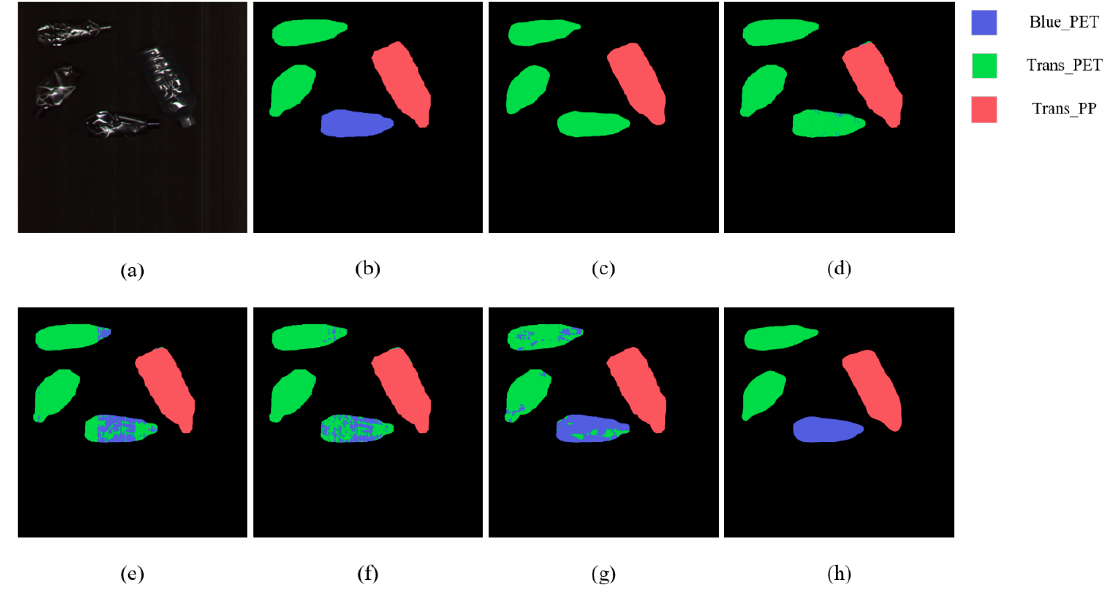
Figure 8. Classification maps for bottles. ( a ) RGB image. ( b ) Ground truth. ( c – h ) Predicted classification maps for SOLOv1, ContextualNet, 3D-CNN, SSRN, HybridSN, and proposed RHFF-SOLOv1, respectively.